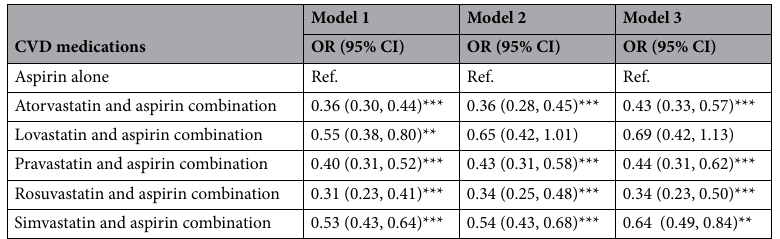
Table 2. Associations of aspirin alone compared to aspirin plus statin with the risk of total CVD. Model 1: age and gender. Model 2: Model 1 variables plus education level, race/ethnicity, family poverty-income ratio, hypertension, diabetes mellitus, smoker, alcohol user, and body mass index. Model 3 was adjusted for Model 2 variables plus physical activity, total energy intake, high-density lipoprotein-cholesterol, total cholesterol, triglyceride, uric acid, creatinine, blood urea nitrogen, and hemoglobin. CVD cardiovascular disease, OR odd ratio, CI confidence interval. ** P < 0.01, *** P < 0.001.